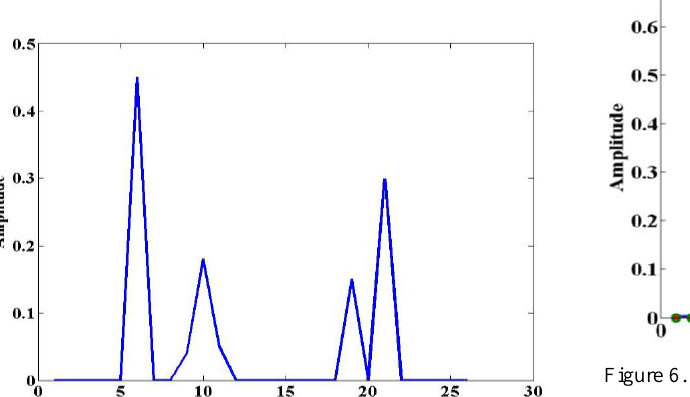
Figure 2. Cross section sample 1